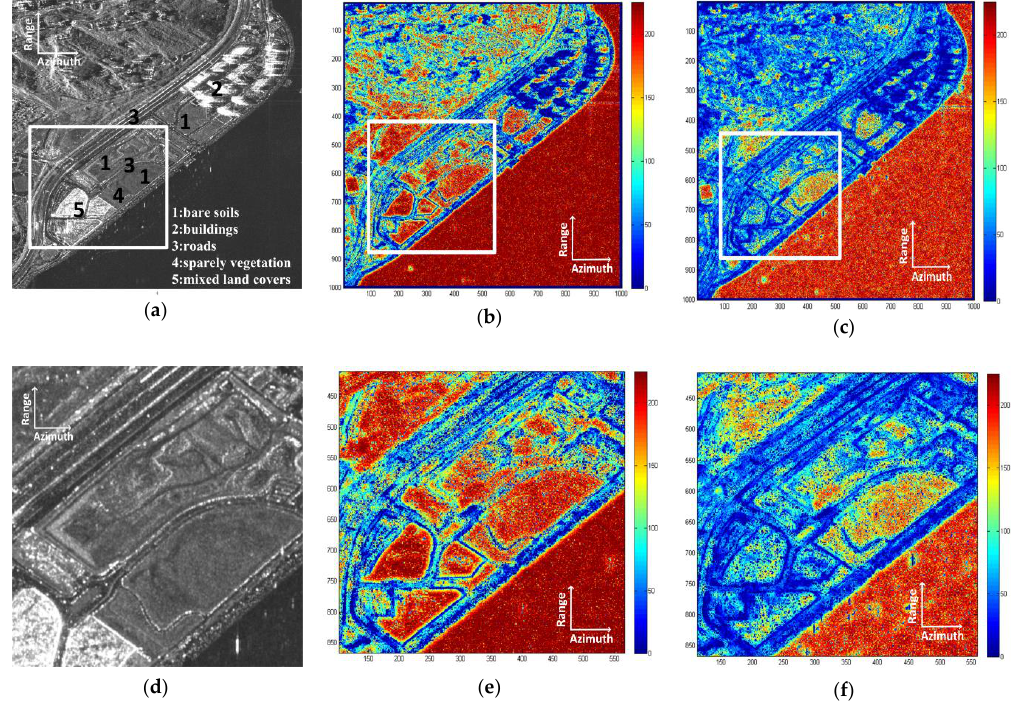
Figure 15. ( a ) The TerraSAR-X temporally averaged amplitude image over HKSP. ( b ) and ( c ) represent the number of SHP maps identified by the KS test and FaSHPS with 15*15 window sizes. ( d ), ( e ) and ( f ) are the zoomed-in maps in the white rectangles in ( a ), ( b ) and ( c ), respectively.